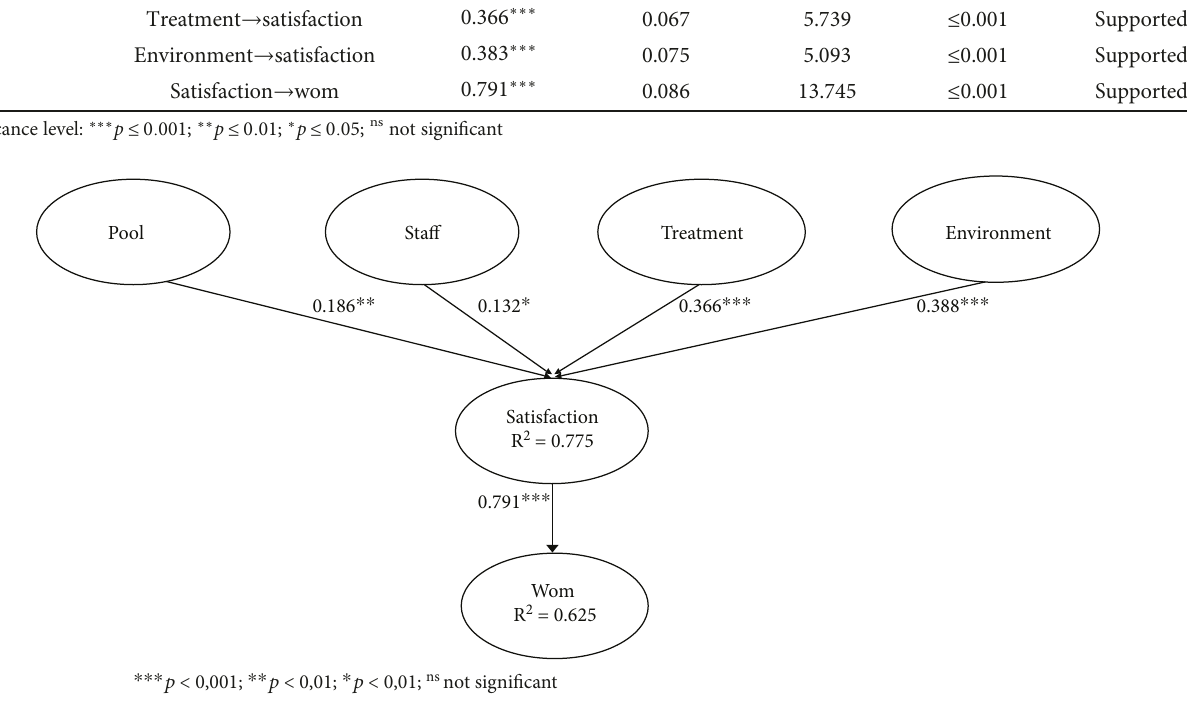
Figure 1: Structural model.